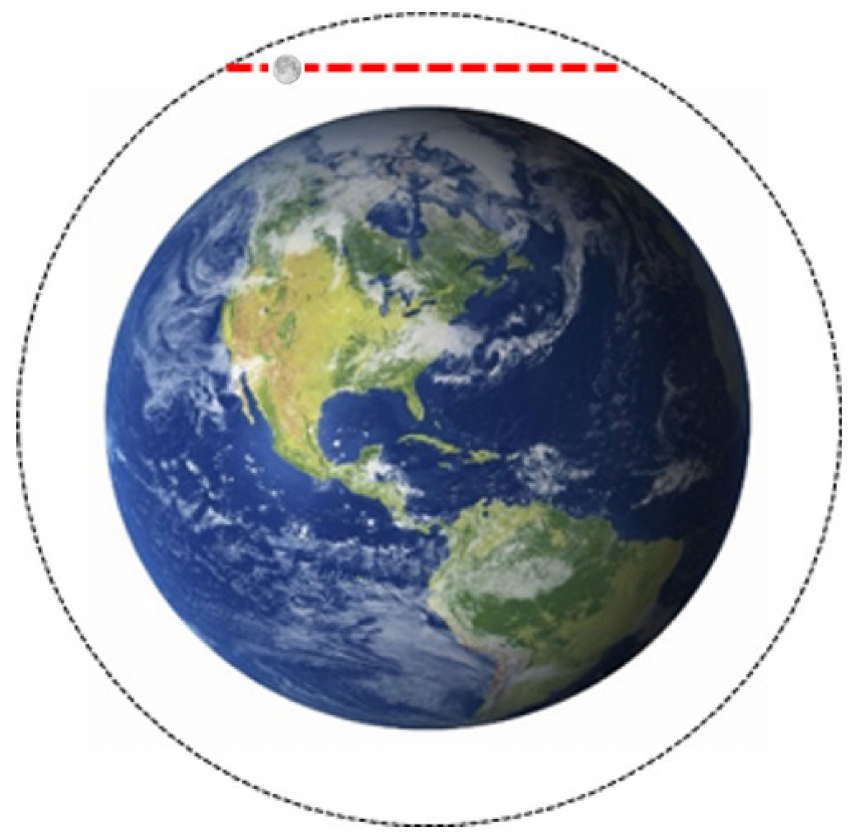
Figure 1. Illustration of ABI FOR (the circle in thin dotted line), with the Earth in the center and the Moon traversing along the red dashed line through part of ABI’s